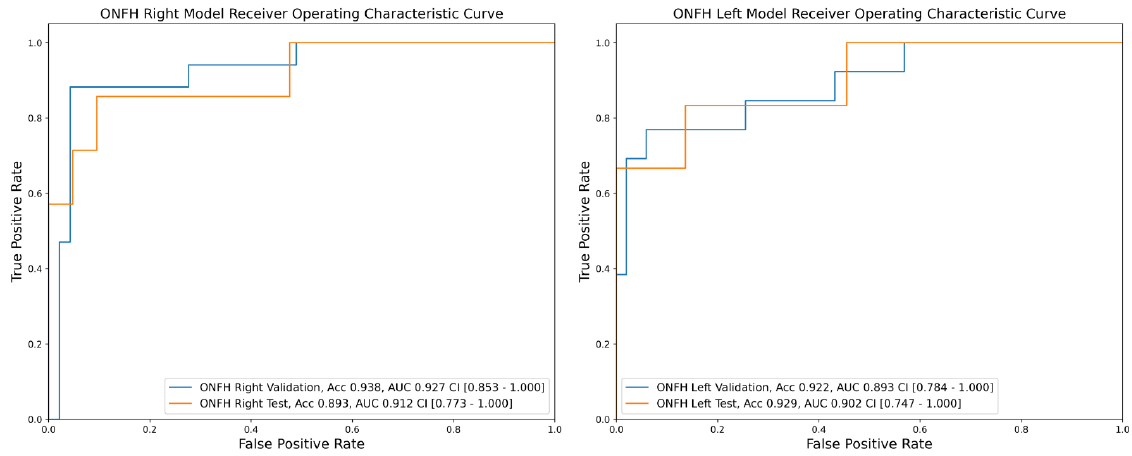
Figure 3. Receiver operating characteristic curve for the validation and test dataset of the anteroposterior pelvic radiographs for the convolutional neural network algorithms for diagnosing osteonecrosis of the femoral head of right and left hips; ONFH, Osteonecrosis of the femoral head; Acc, accuracy; AUC, area under the